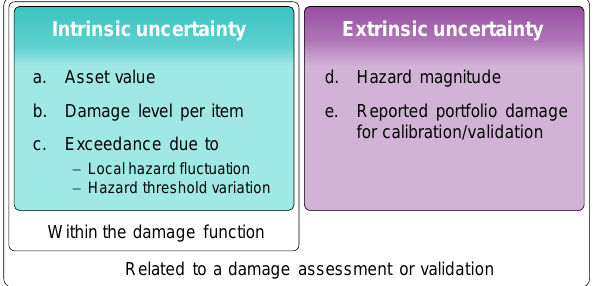
Figure 3. Classification of the sources of uncertainty into intrinsic and